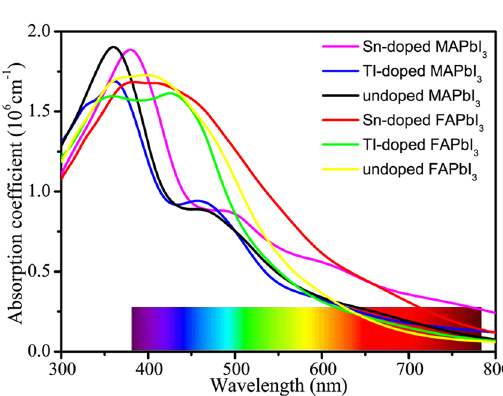
Figure 4. The calculated optical absorption spectra of the doped and undoped MA(FA)PbI 3 . The violet, blue, black, red, green, and yellow lines represent the optical absorption spectra of the Sn-doped MAPbI 3 , TI-doped MAPbI 3 , un-doped MAPbI 3 , Sn-doped FAPbI 3 , TI-doped MAPbI 3 and un-doped MAPbI 3 ,